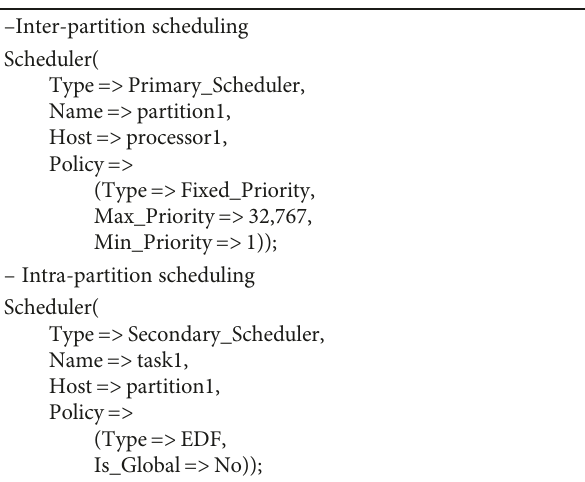
Table 11: End_To_End_Flow model element